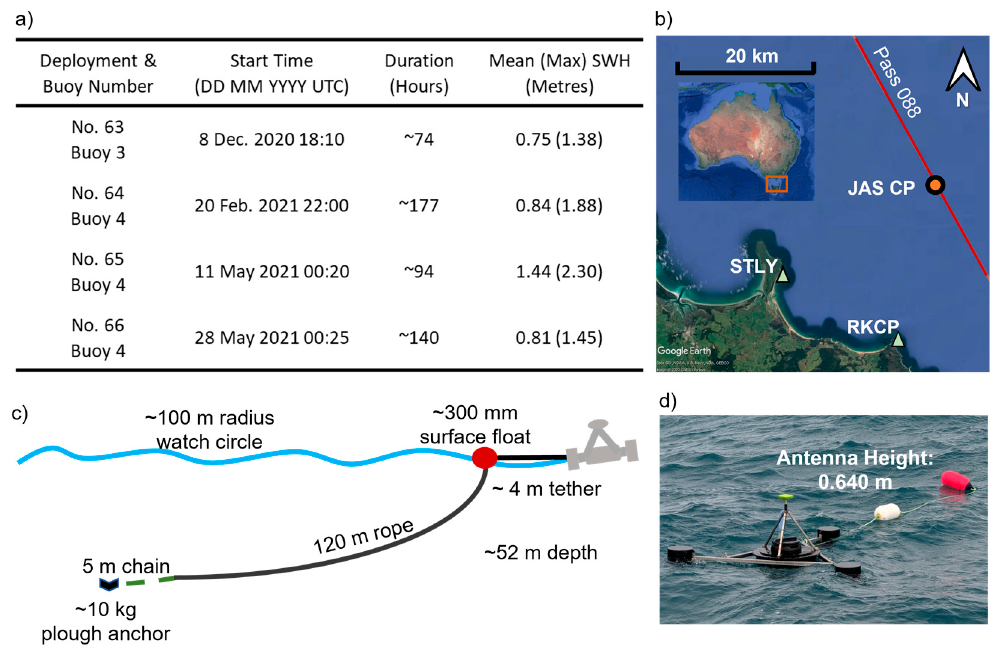
Figure 1. General information describing the GNSS/INS buoy deployments considered and the deployment configuration adopted with respect to land-based reference stations. Panel ( a ) provides mean and maximum (max) sea state during the deployment along with the start time and the duration of the corresponding deployment; Panel ( b ) shows the location of the studied area (red rectangle box) with respect to Australia and the buoy location (JAS CP) with respect to two land-based reference stations; Panel ( c ) illustrates the schematic anchor/float/tether system of the buoy deployment setup; Panel ( d ) is the image of the Mk-IV buoy with antenna height from the water to the Antenna Reference Point (ARP) as measured in a controlled laboratory environment.